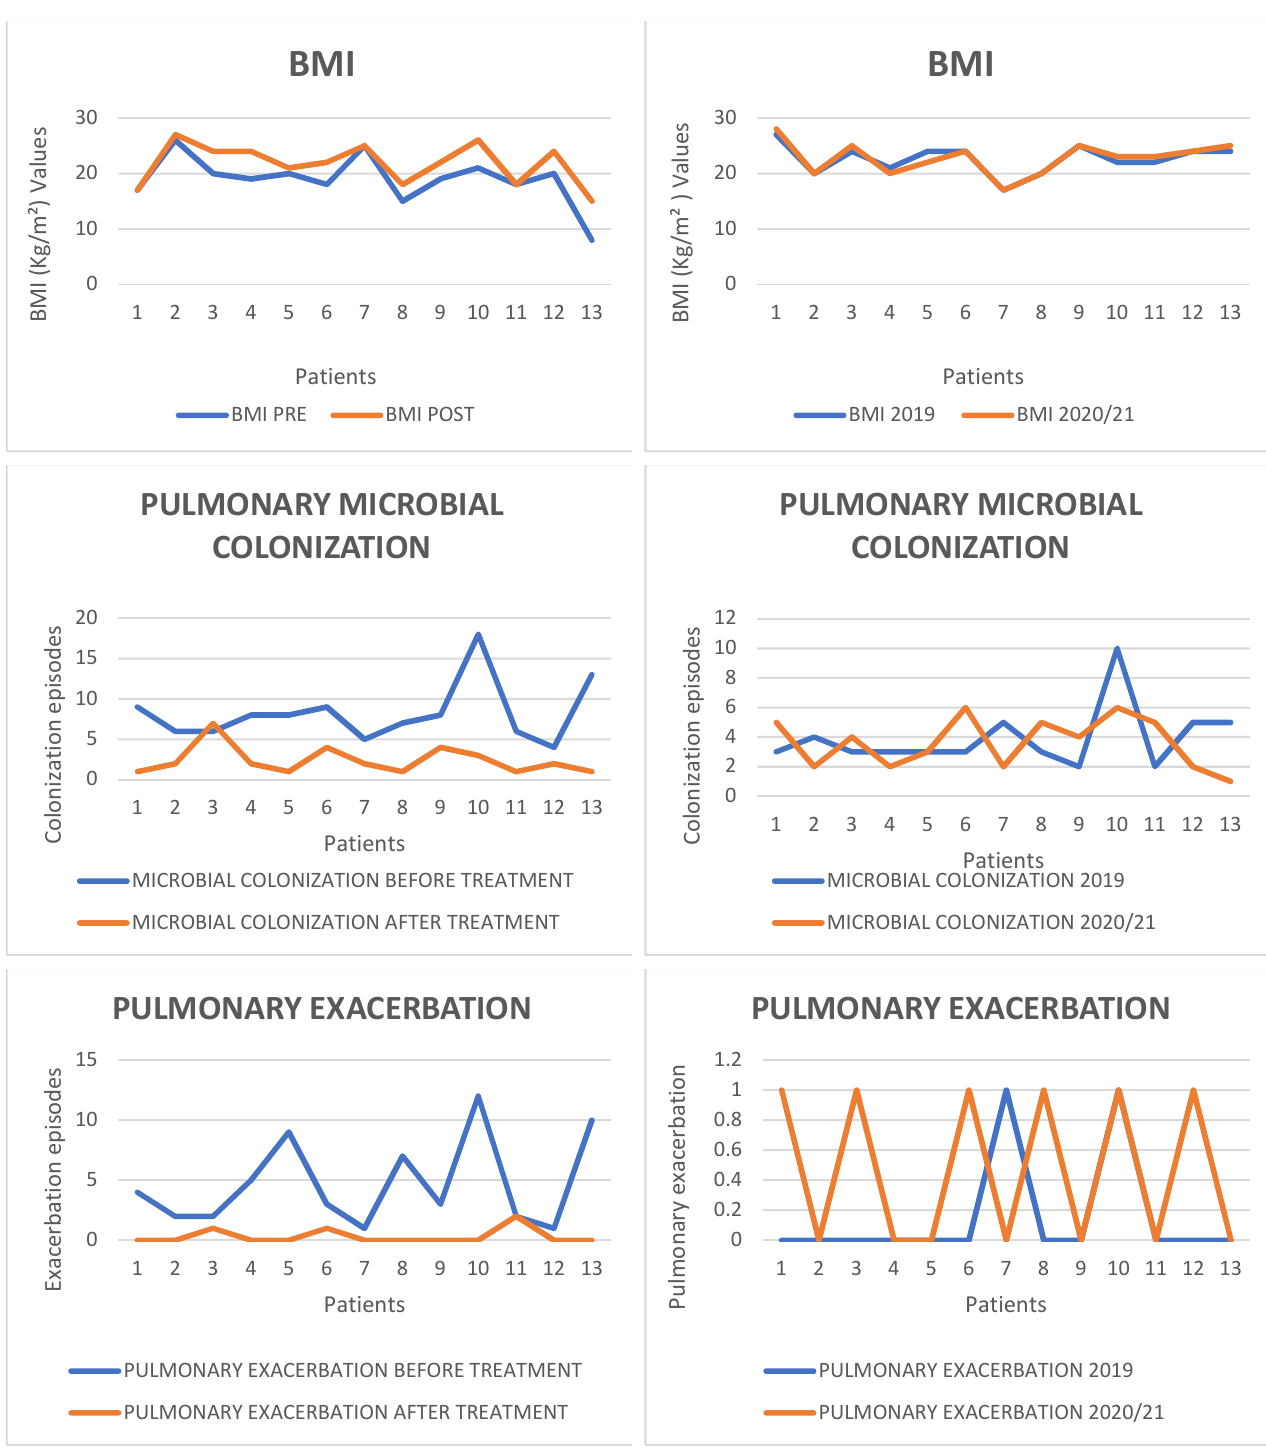
Figure A1: Comparison charts on clinical and microbiological results Figure A1. Comparison charts on clinical and microbiological